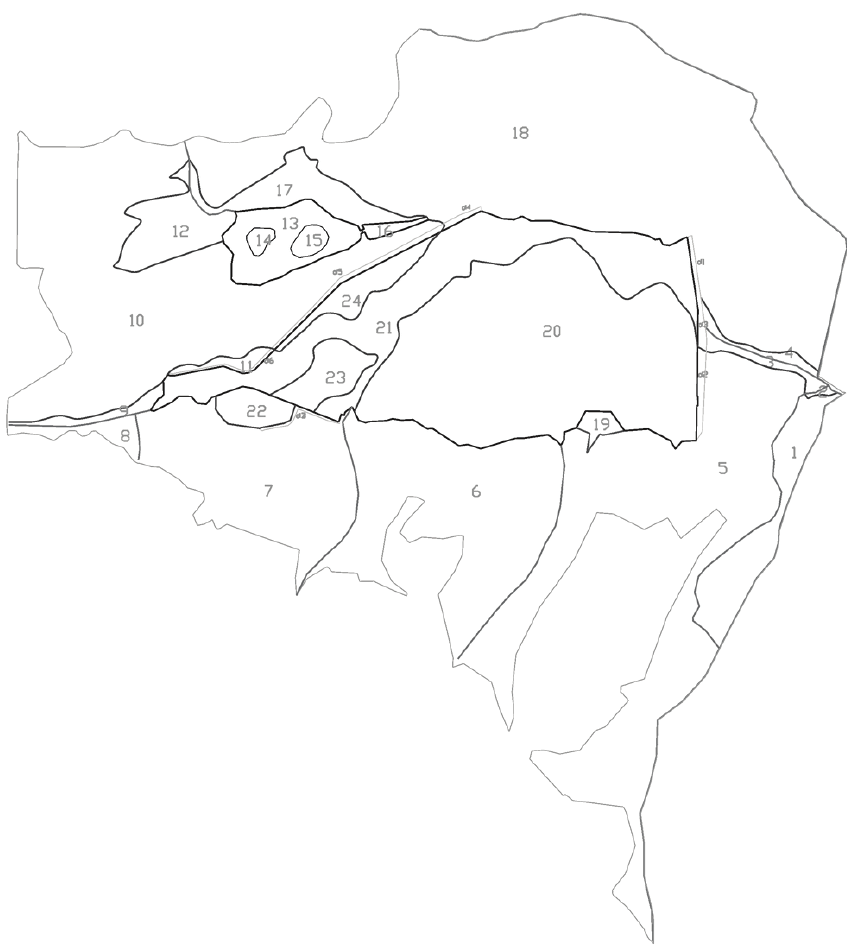
Fig. 6. Division of seepage flow area into